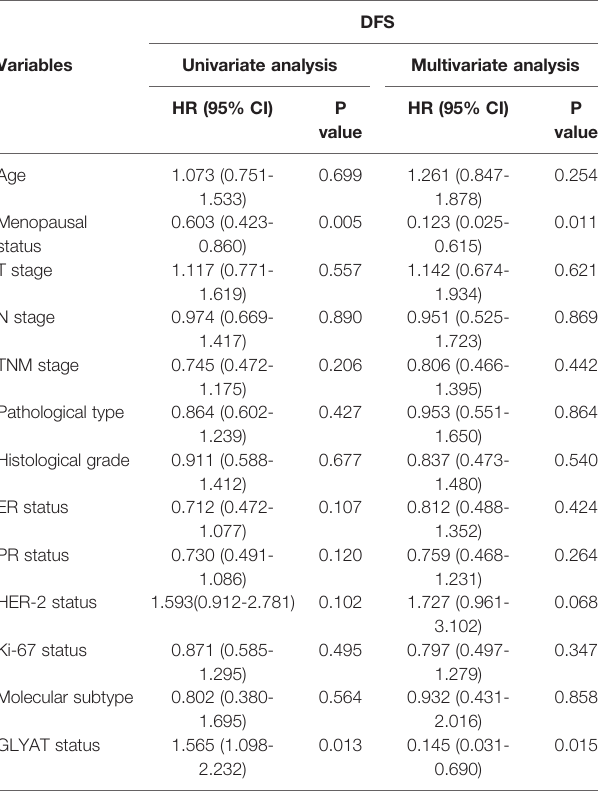
TABLE 2 | Univariate and multivariate analyses of clinicopathological risk factors for disease-free survival among breast cancer